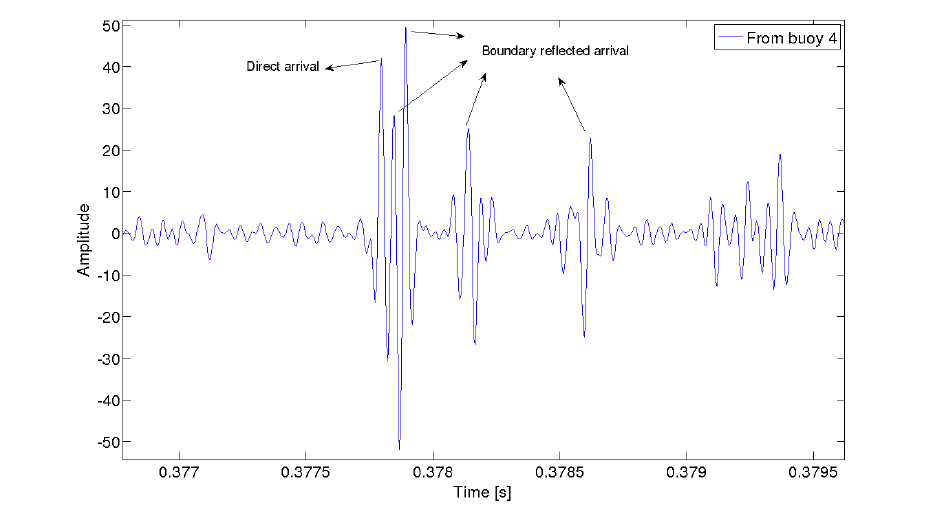
Figure 4. Autocorrelation peaks at buoy 1 with the code from buoy